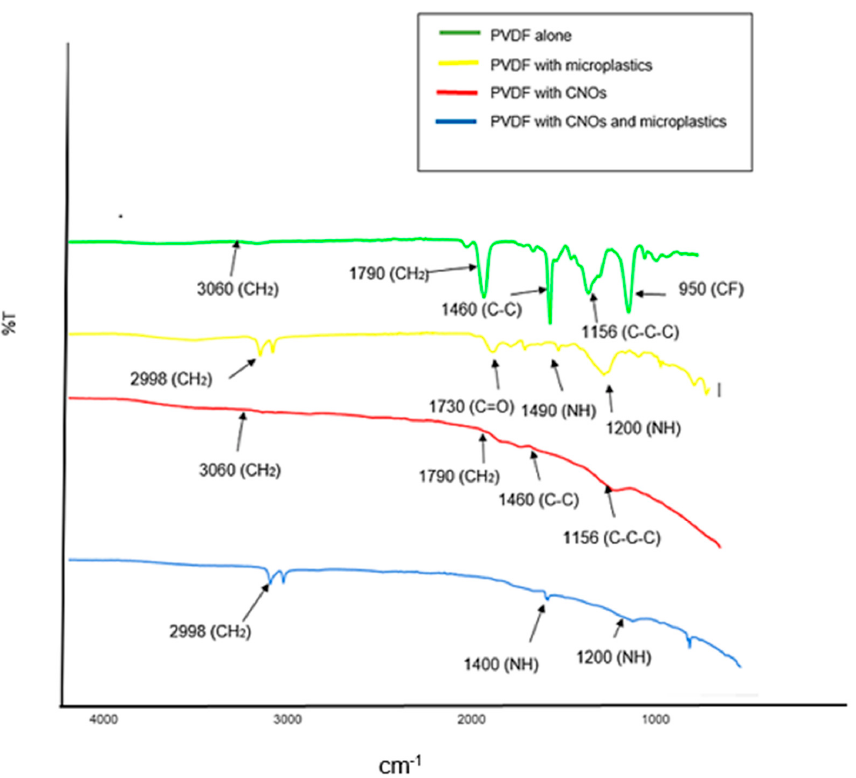
Figure 7. ATR-FTIR spectra of PVDF and PVDF/CNOs membranes with microplastics obtained from a wastewater influent sample. Table 4. Standard samples used for the analysis of heavy metals by